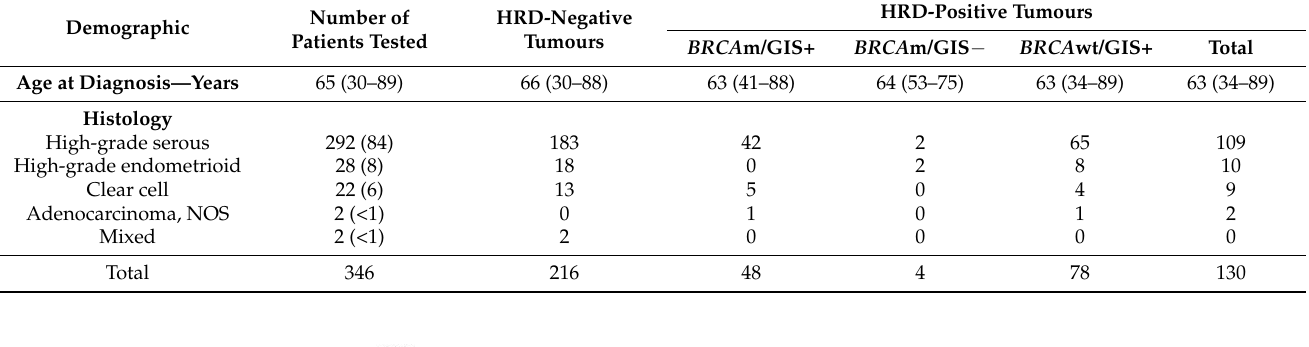
Table 3. Demographic data for patients that were tested using Myriad’s myChoice ® CDx. Data are presented as mean (range) or number (percentage; the denominator being the ‘Total’). Key: BRCA m, BRCA1/2 pathogenic variant; BRCA wt, BRCA1/2 wild type; GIS-, GIS-negative; GIS+, GIS-positive; NOS, not otherwise specified. The four BRCA m/GIS- tumors included germline BRCA2 Exon 14-16 deletion (GIS 36), somatic BRCA1 Exon 13-24 deletion (GIS 34), somatic BRCA2 c.9097dup (GIS 5) and somatic BRCA2 c.3760G>T (GIS 24).